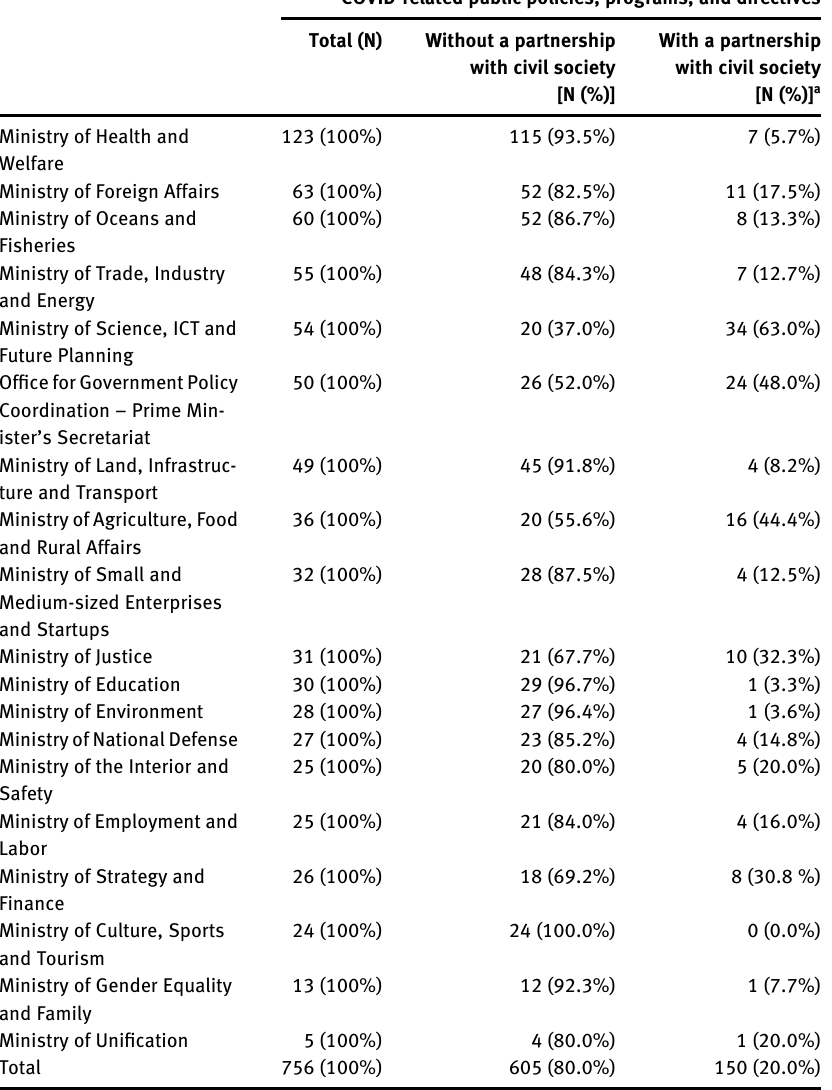
Table  : COVID-relatedpublicpolicies,programs,anddirectives(civilsocietypartnershipstatus).